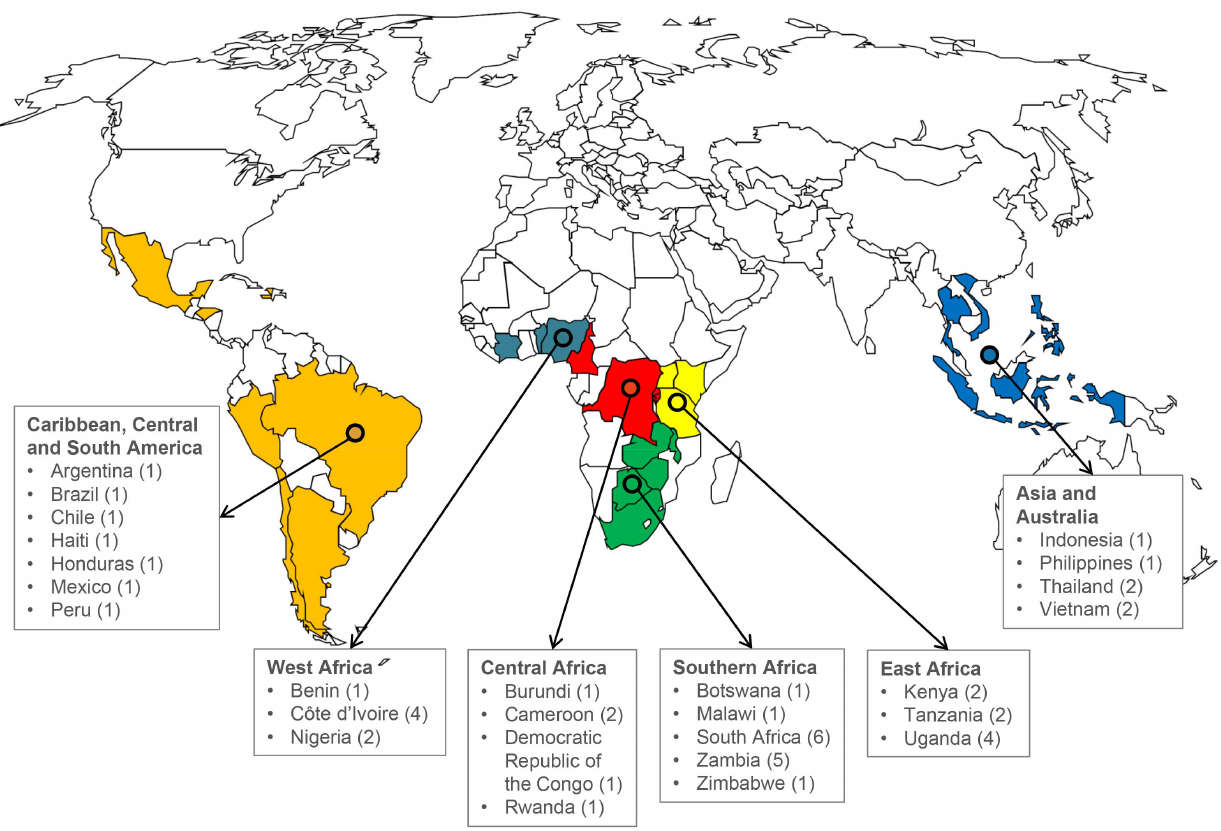
Figure 1. Geographical distribution of the 47 ART programs the International epidemiologic Databases to Evaluate AIDS (IeDEA) collaboration, which treat adults in lower income countries and participated in the survey project. The regions correspond to the IeDEA regions. Countries with at least one site completing Section A of the questionnaire are shown. Numbers in parentheses indicate the number of adult ART programs included in the analysis.